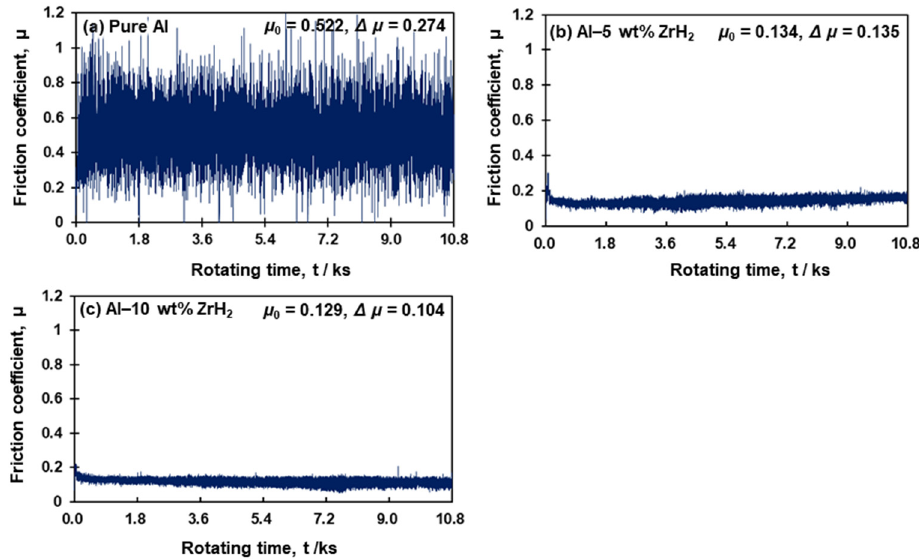
Figure 5. Changes in the friction coefficient of SUS304 disc under an applied load of 4.9 N using ( a ) pure Al, ( b ) Al–5 wt% ZrH 2 , and ( c ) Al–10 wt% ZrH 2 pin specimens. ( a ) pure Al, ( b ) Al–5 wt% ZrH 2 , and ( c ) Al–10 wt% ZrH 2 pin